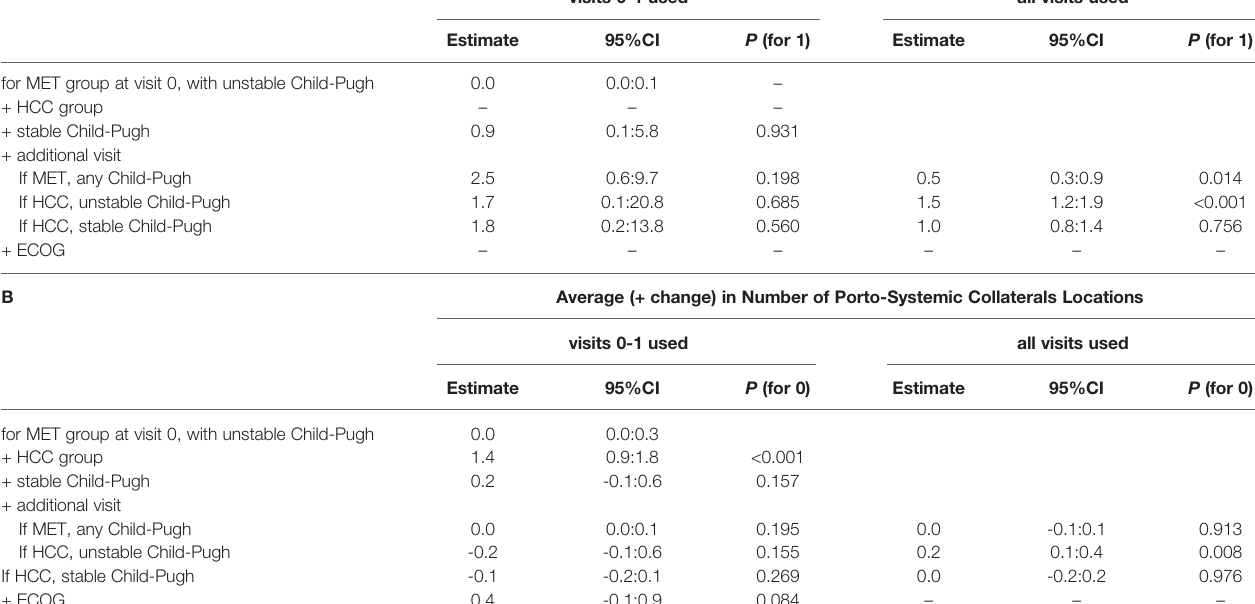
Odds (+ Odds Ratios) of Having Moderate/Severe Ascites visits 0-1 used